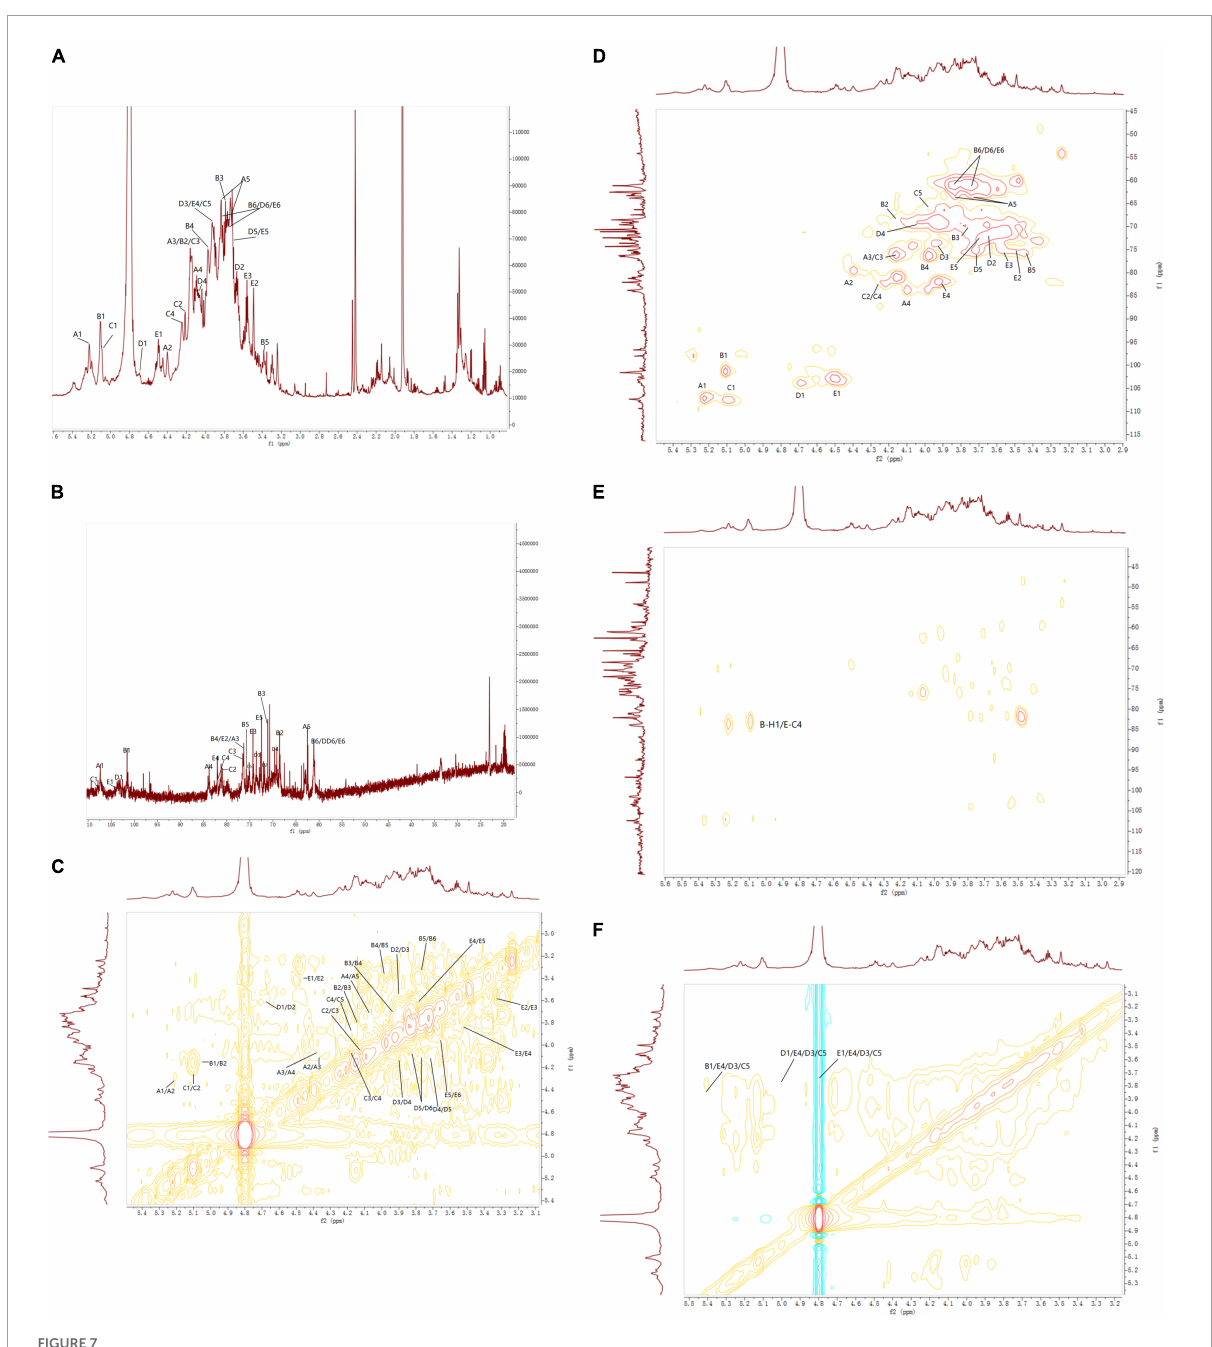
FIGURE7 NMR spectra of EFP-3 in elderberry. (A) 1H NMR; (B) 13C NMR; (C) 1H-1H COSY; (D) HSQC; (E) 5-HMBC; and (F)